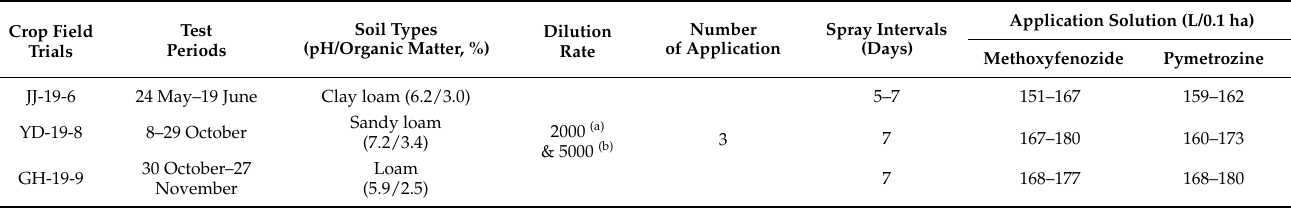
Table 1. Detailed information on field trials and pesticide